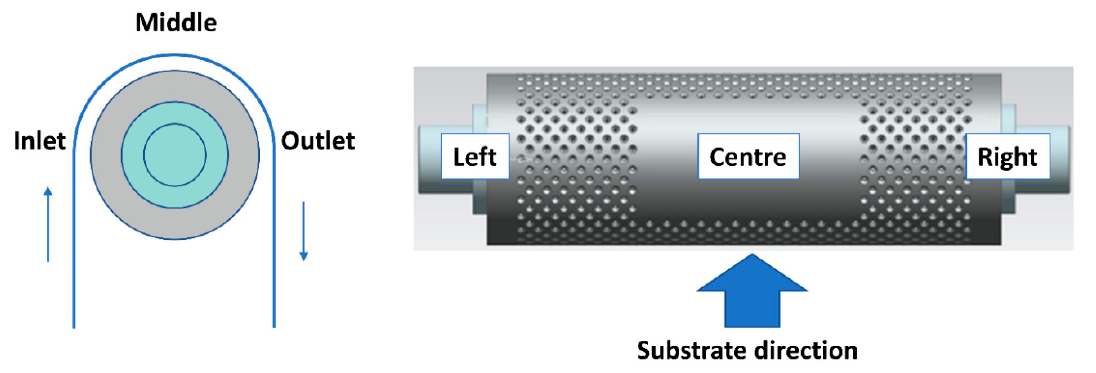
Figure 8. Side and top views of the designated locations for flotation measurements. Table 2. Measured flotation height as a function of velocity, blower frequency, and